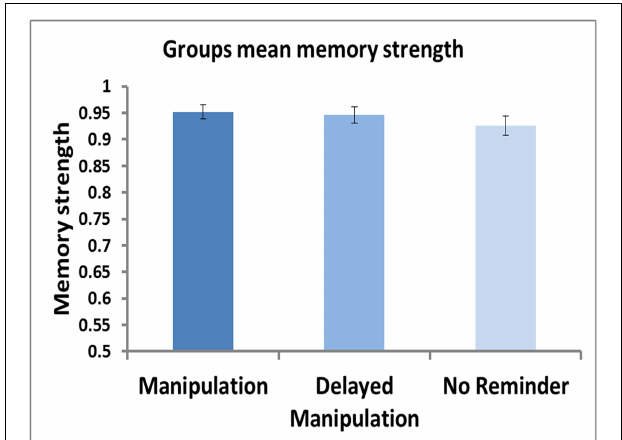
FIGURE 2 | Group means of memory strength. Mean memory strength, calculated as the ratio of test2/test1, shown for each of the three groups (Manipulation Group, Delayed Manipulation Group, and No Reminder Group). No significant differences were found between the 3 groups [One-Way ANOVA: F (2 , 74) = 0 . 75, p = 0 .